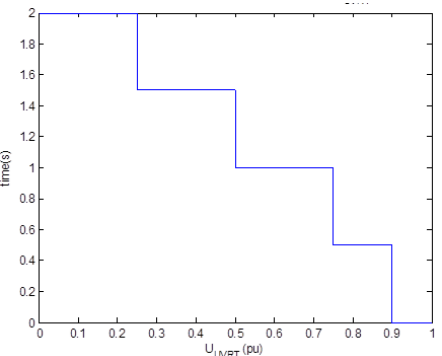
Figure 11. Time the protection system will be activated depending on U UVRT .